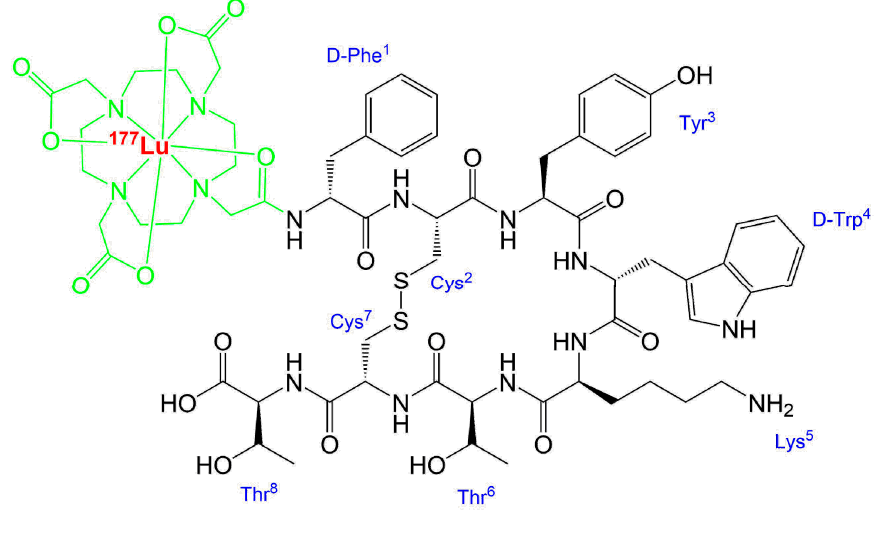
Figure 1. Structure of [ 177 Lu]Lu-DOTA-TATE (Lutathera ® ). Simplified writing of complexation